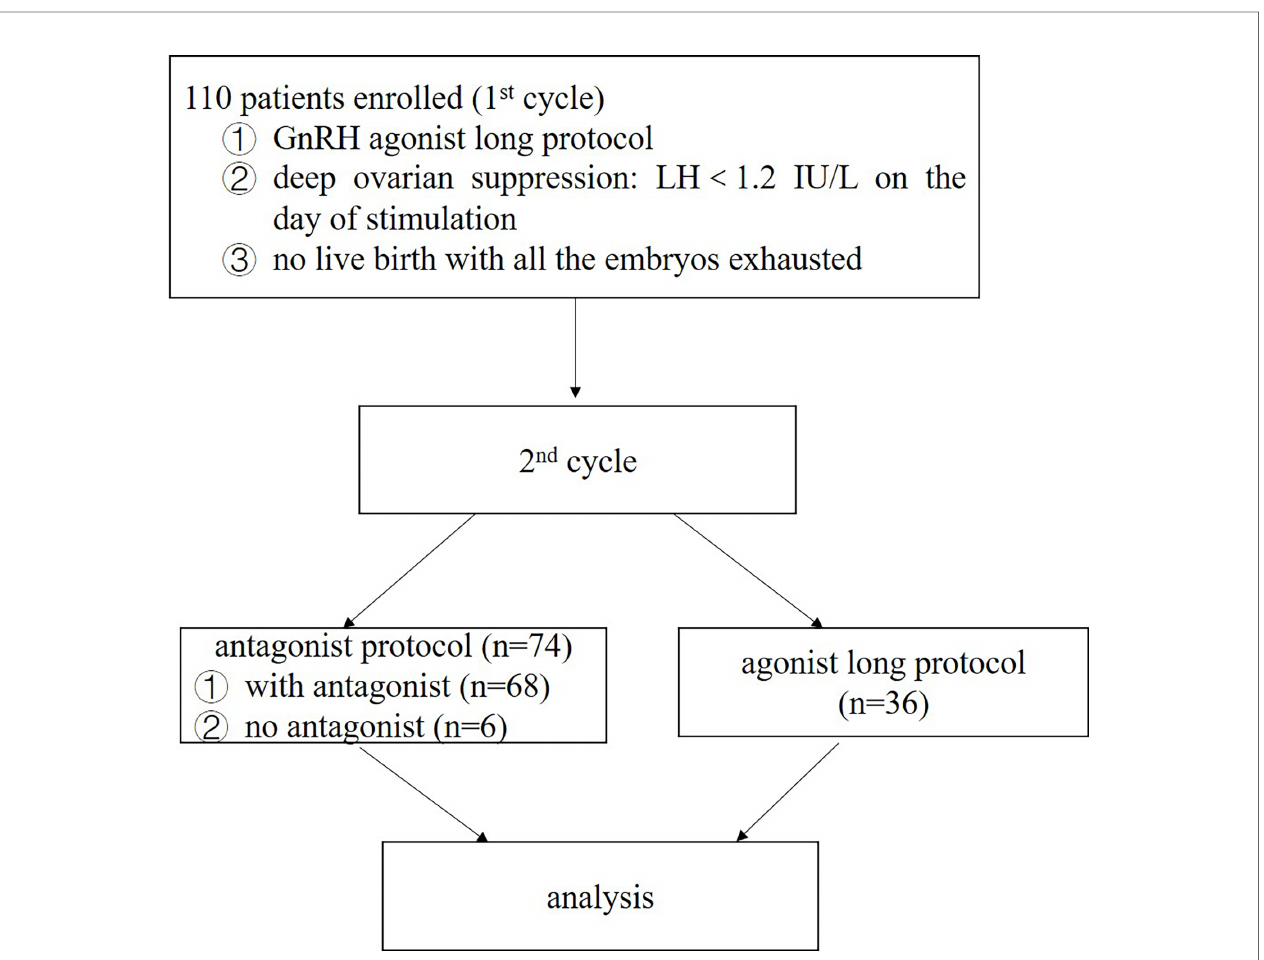
FIGURE 1 | Flowchart of patient fl